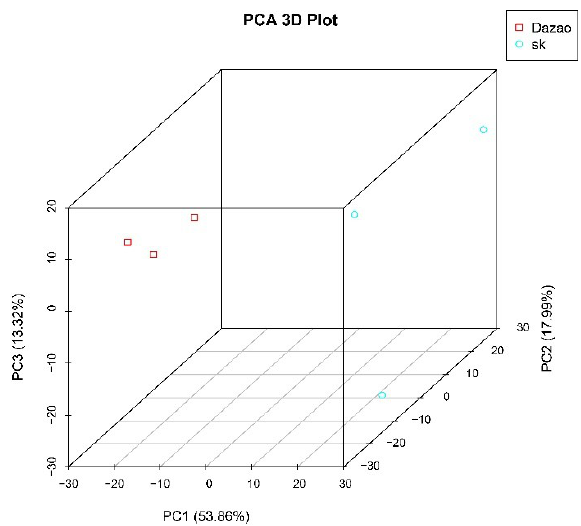
Figure 3. Principal component analysis (PCA) for all RNA-Seq sample. Dazao are represented by the red dots, the sk mutants are indicated by the blue dots.